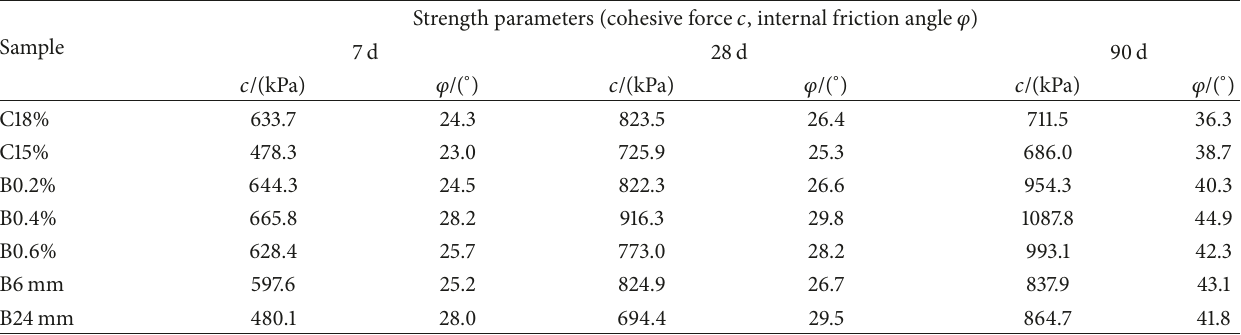
Table 9: Shear strength index of the cement-soil with basalt fibre reinforced for different curing